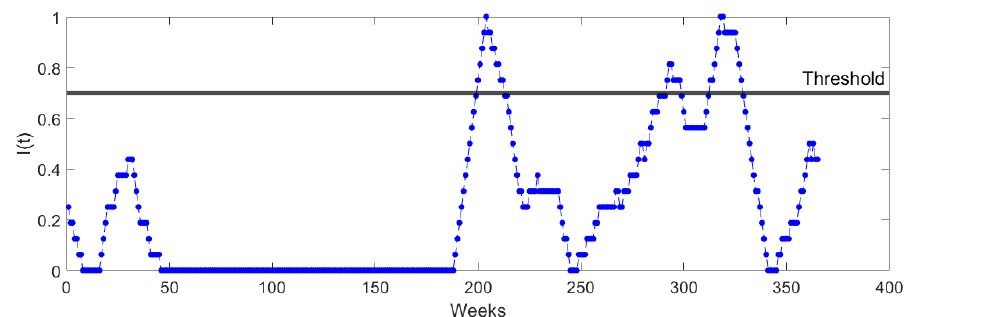
Figure 11. MRDM applied to the 1 min bitcoin